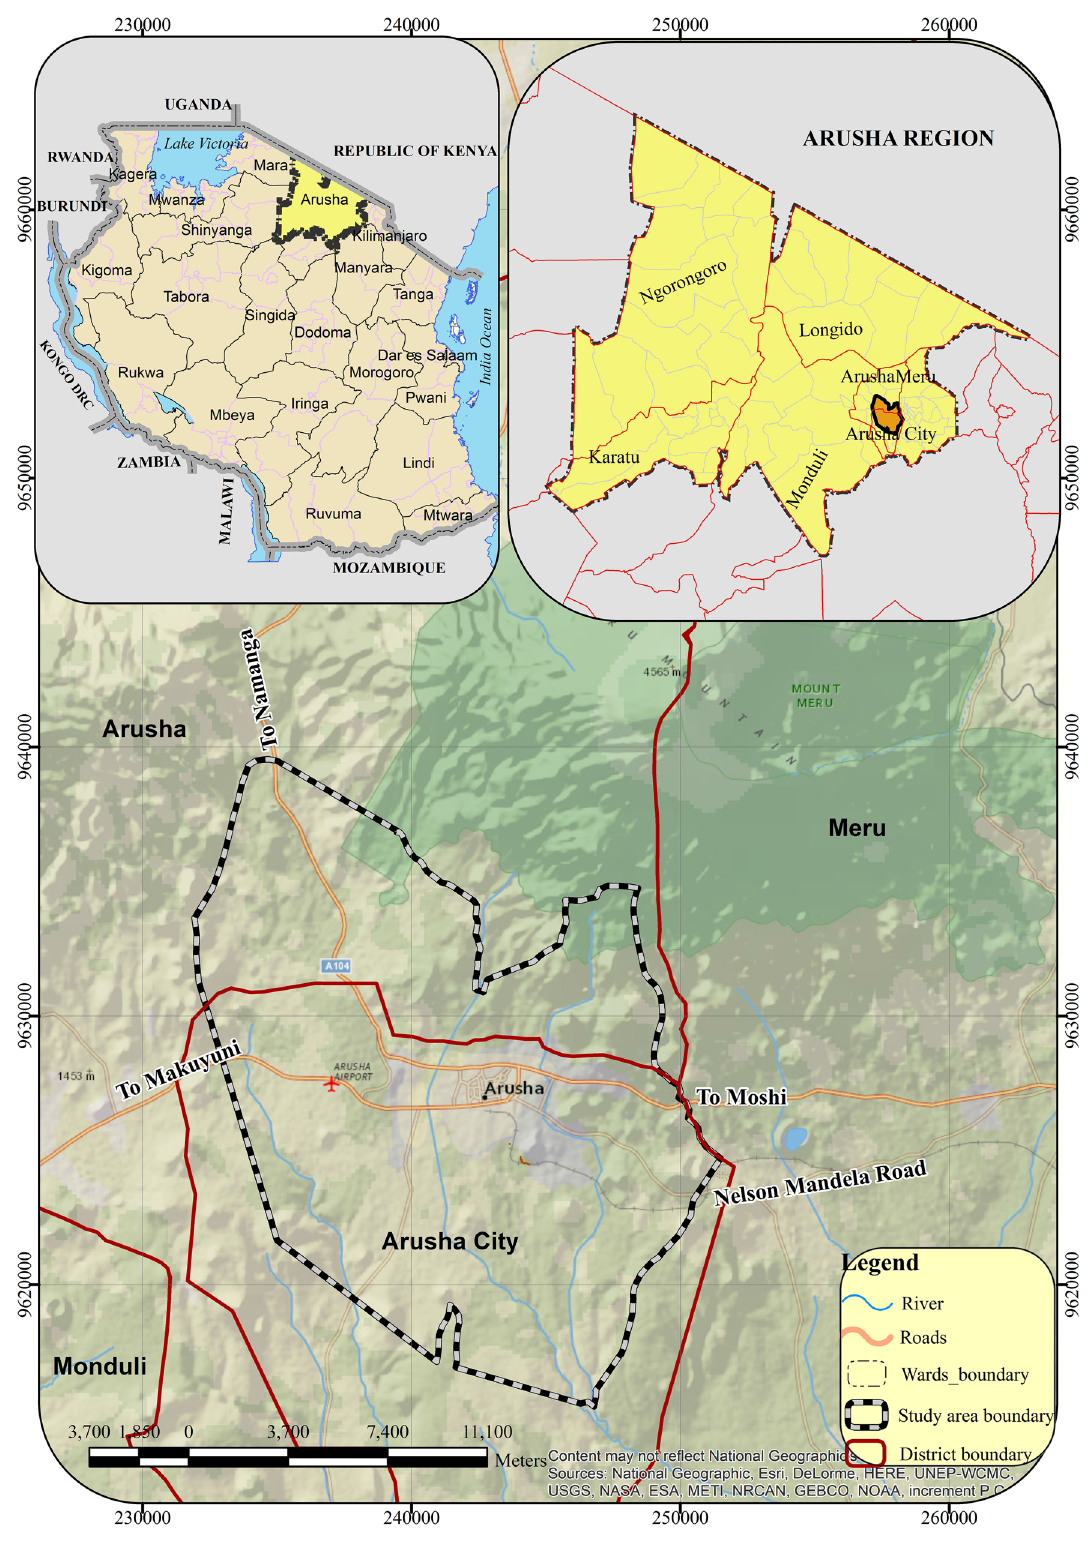
Fig. 1 Location of the study